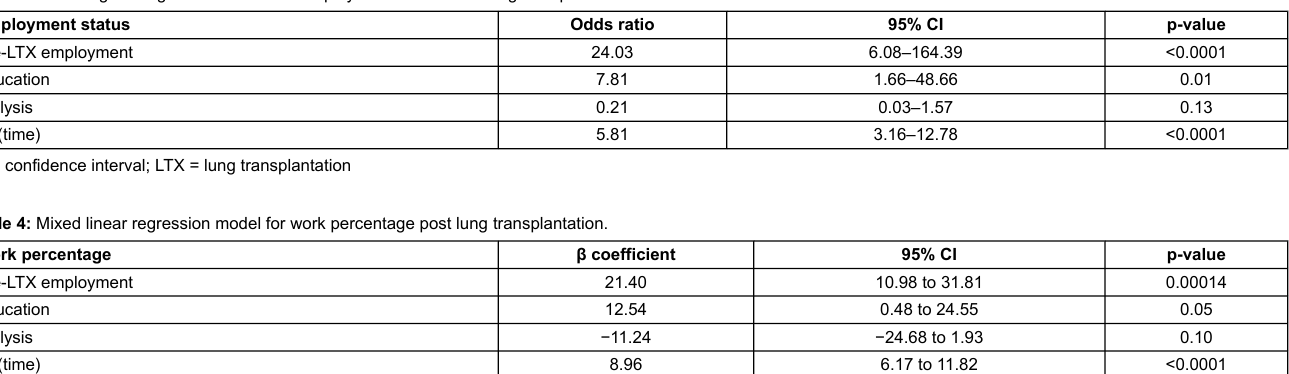
Table 3: Mixed logistic regression model for employment status after lung transplantation.